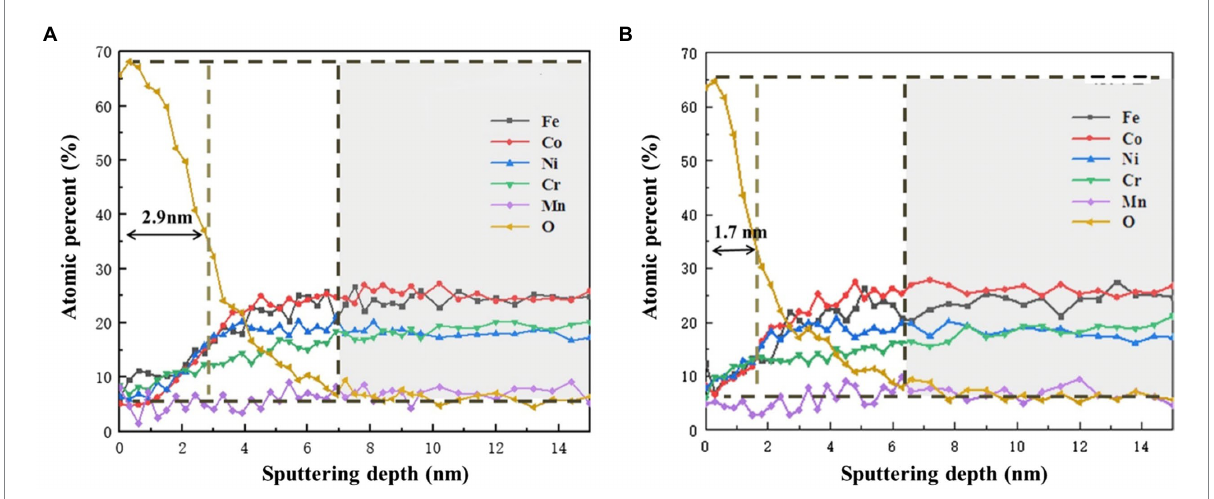
FIGURE 9 AES depth profiles of Fe, Cr, Co, Ni, Mn and O in the passive film on the HEA (A) in the sterile medium and (B) in the P. aeruginosa -inoculated medium.